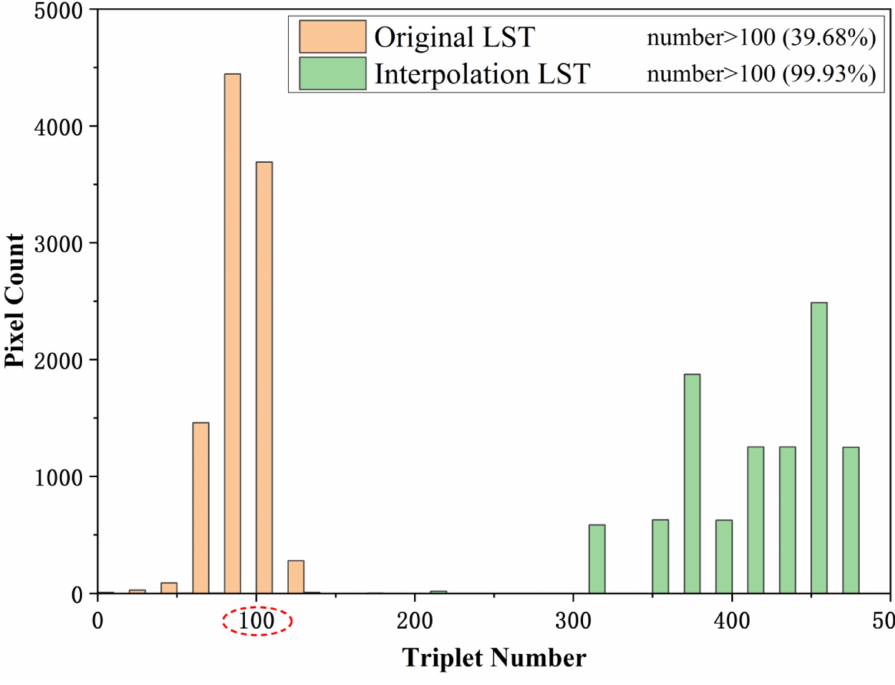
Figure 4. A comparison histogram of the number of available triples (orange columns are the number of triples before LST interpolation, green columns are after